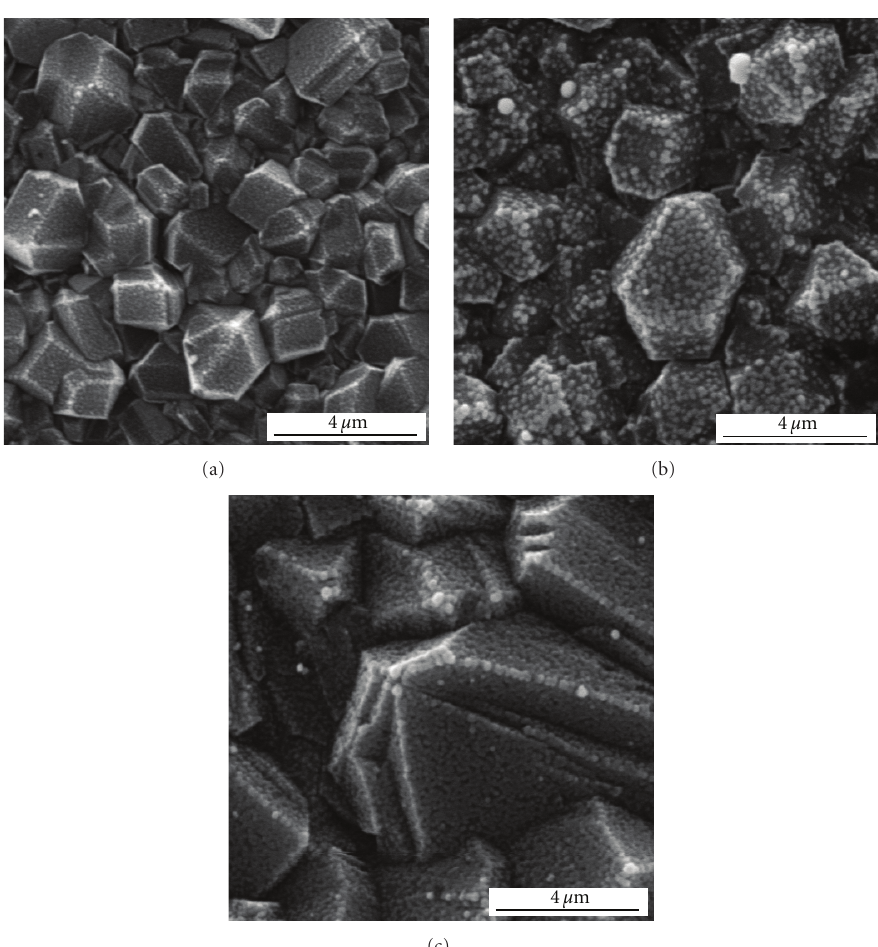
Figure 5: SEM images of the Cu/Pd composite electrodeposited on BDD electrode in solutions with di ff erent Cu(II): Pd(II) ratio: (a) (1:1), (b) (5:1), and (c) 10:1. All were deposited applying − 0.3V by 120s.